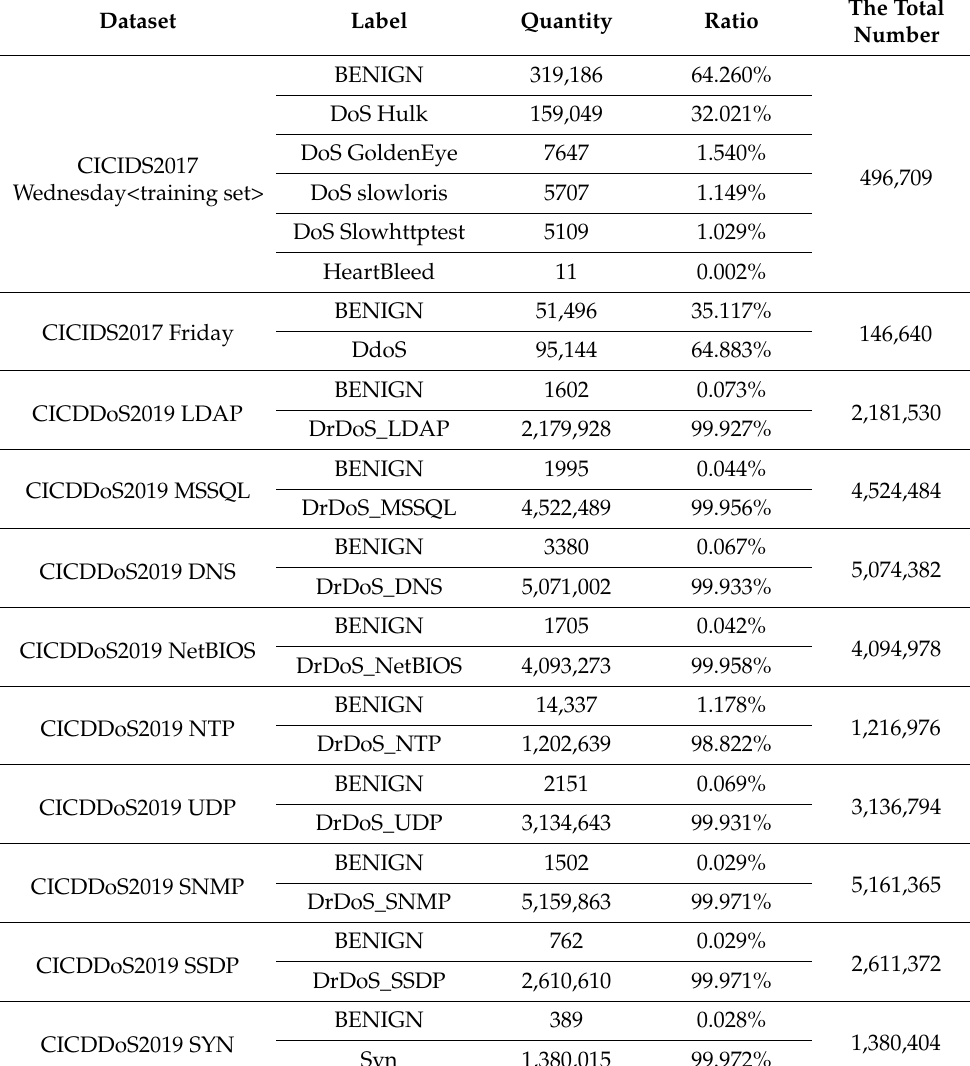
Table 2. Quantitative analysis of